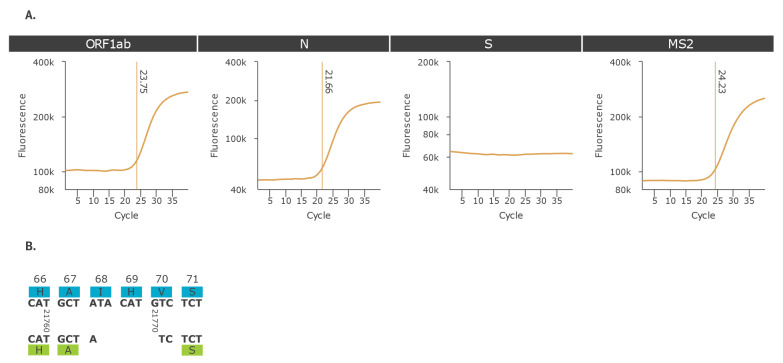
(A) Amplification curvesa obtained with TaqPath COVID-19 RT-PCR kit for samples harbouring SARS-CoV-2 with nt deletion 21765–21770 in the spike gene and (B) pairwise sequence alignment from nt position 21758 to 21775 of a reference spike gene and a spike gene with the 21765–21770 deletion